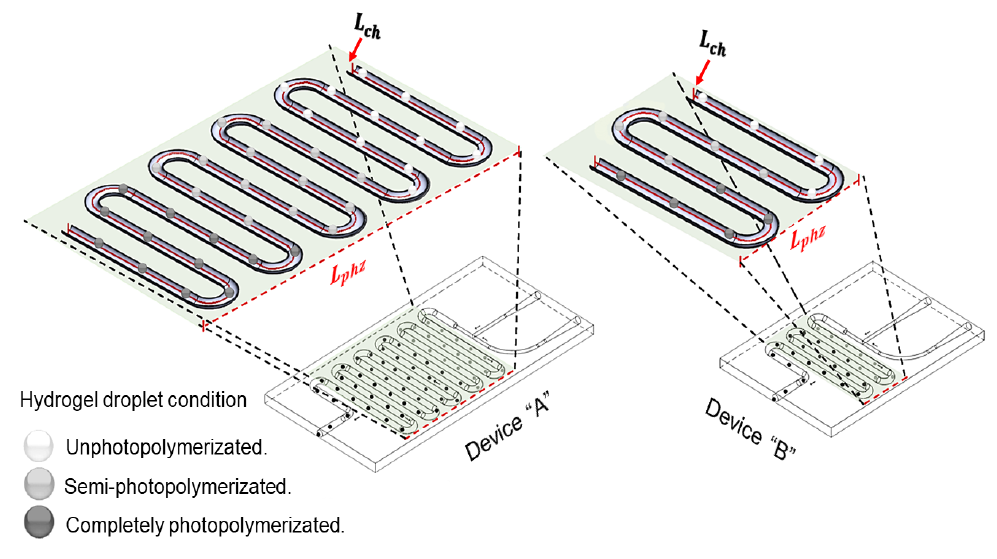
Figure 3. The initial gelation time may be different for different hydrogel formulations. L ch represents the total channel length required to reach the initial gelation point of the hydrogel. The shorter the length of the channel ( L ch ), the smaller the length of the photopolymerization zone ( L phz